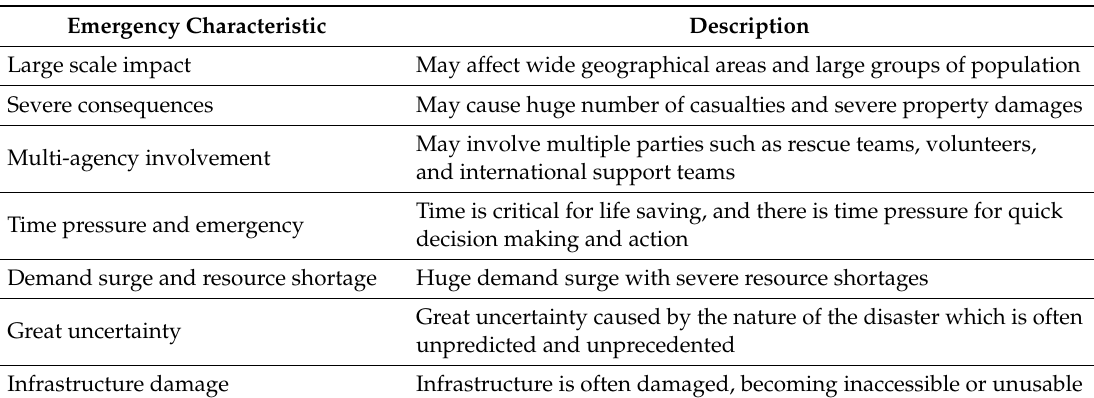
Table 2. Key characteristics of large-scale disasters.